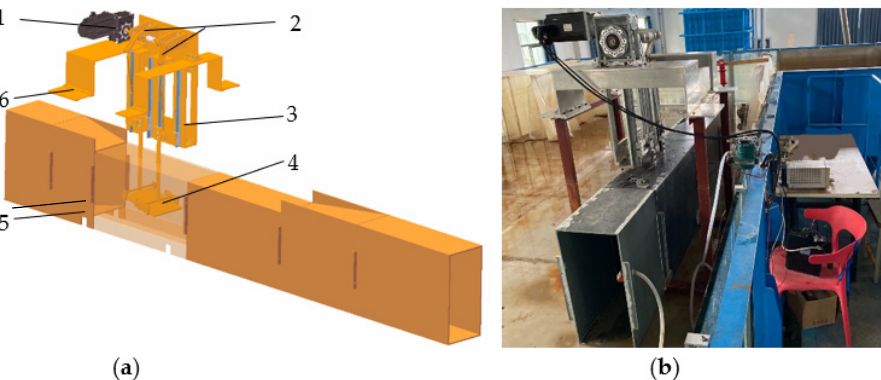
Figure 7. ( a ) Schematic diagram of flapping hydrofoil water pushing device test bench: 1. Motor and reducer; 2. Double crank mechanism; 3. Slide rail; 4. Flapping wing; 5. Contraction and expansion passage; 6. Support frame ( b ) Photograph of the flapping hydrofoil water-pushing device test bench.